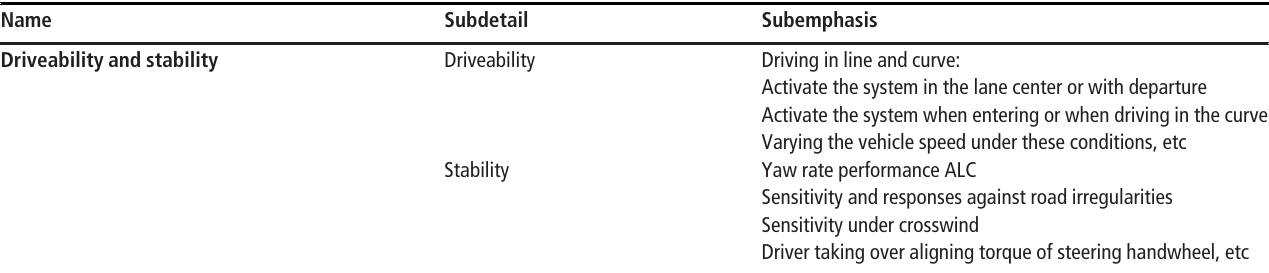
Table 2 Details of the driveability and